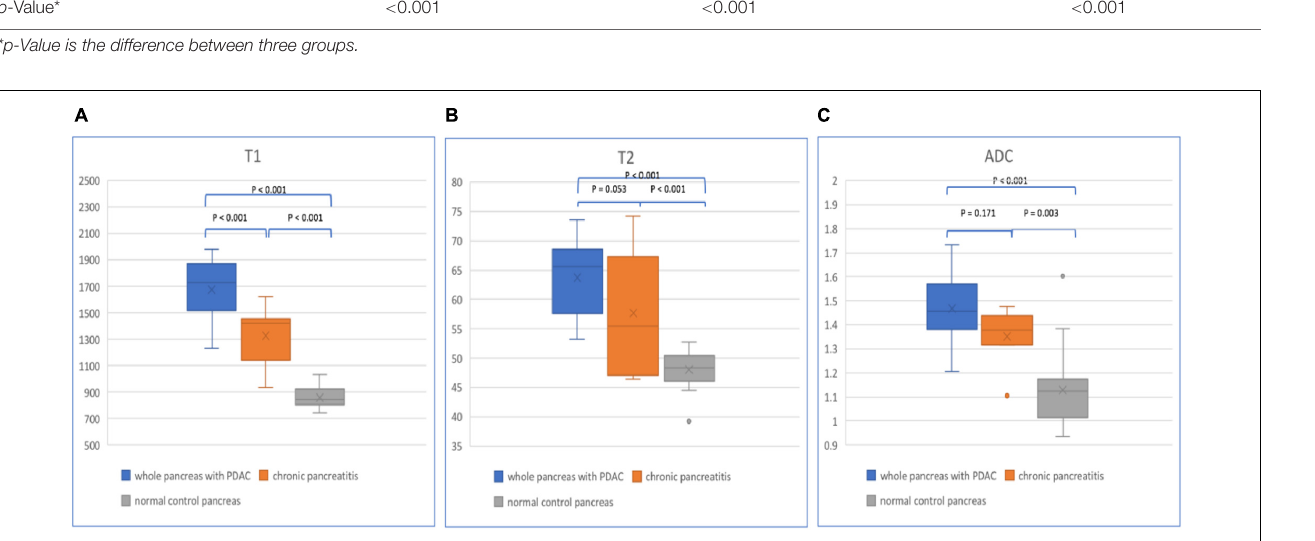
FIGURE 5 | Box plots show T1 (A) , T2 (B) , and ADC (C) values of the whole pancreas with PDAC, CP, and normal control pancreas. p -values are listed on the upper box according to one-way analysis of variance (ANOVA).